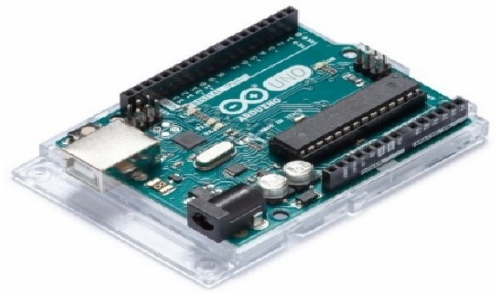
Figure 3. Arduino UNO microcontroller.